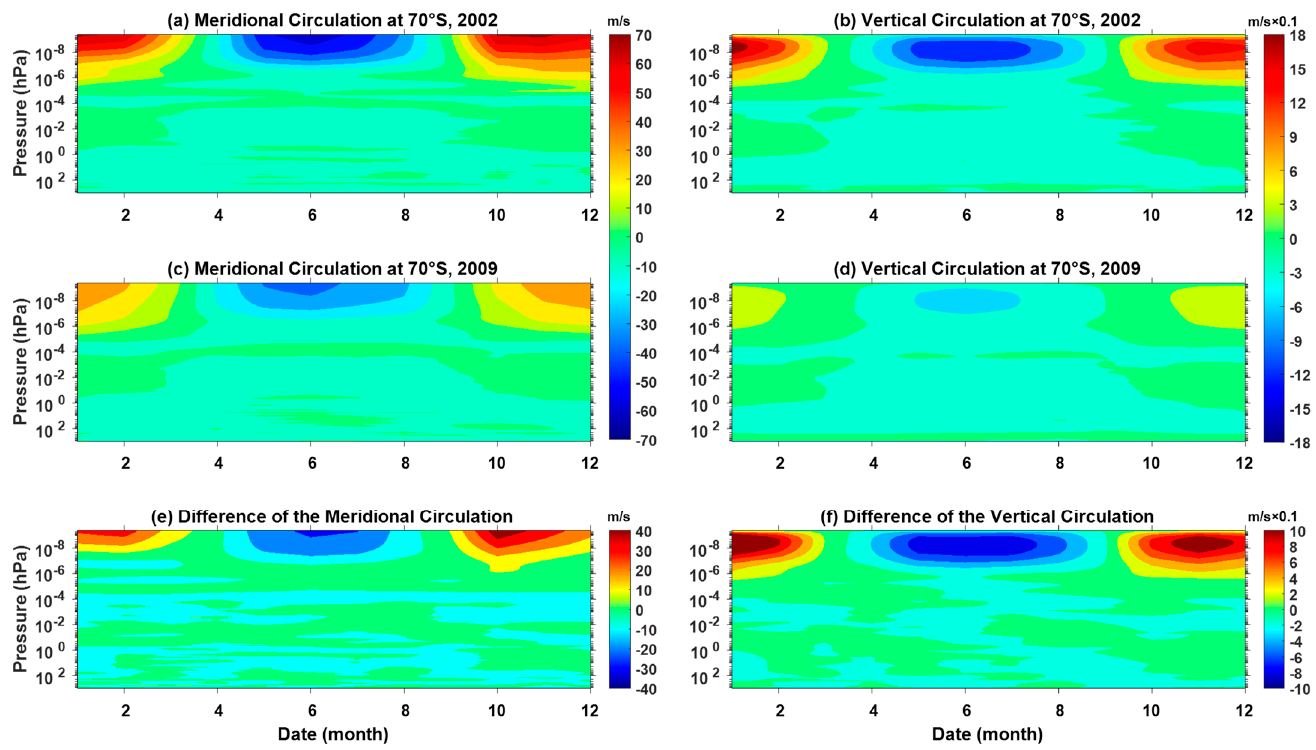
Figure 5. Temporal variations in the ( a , c ) meridional circulation and ( b , d ) vertical circulation at ~70° S in ( a , b ) 2002 and ( c , d ) 2009. ( e , f ) Differences in the meridional and vertical circulation, respectively.